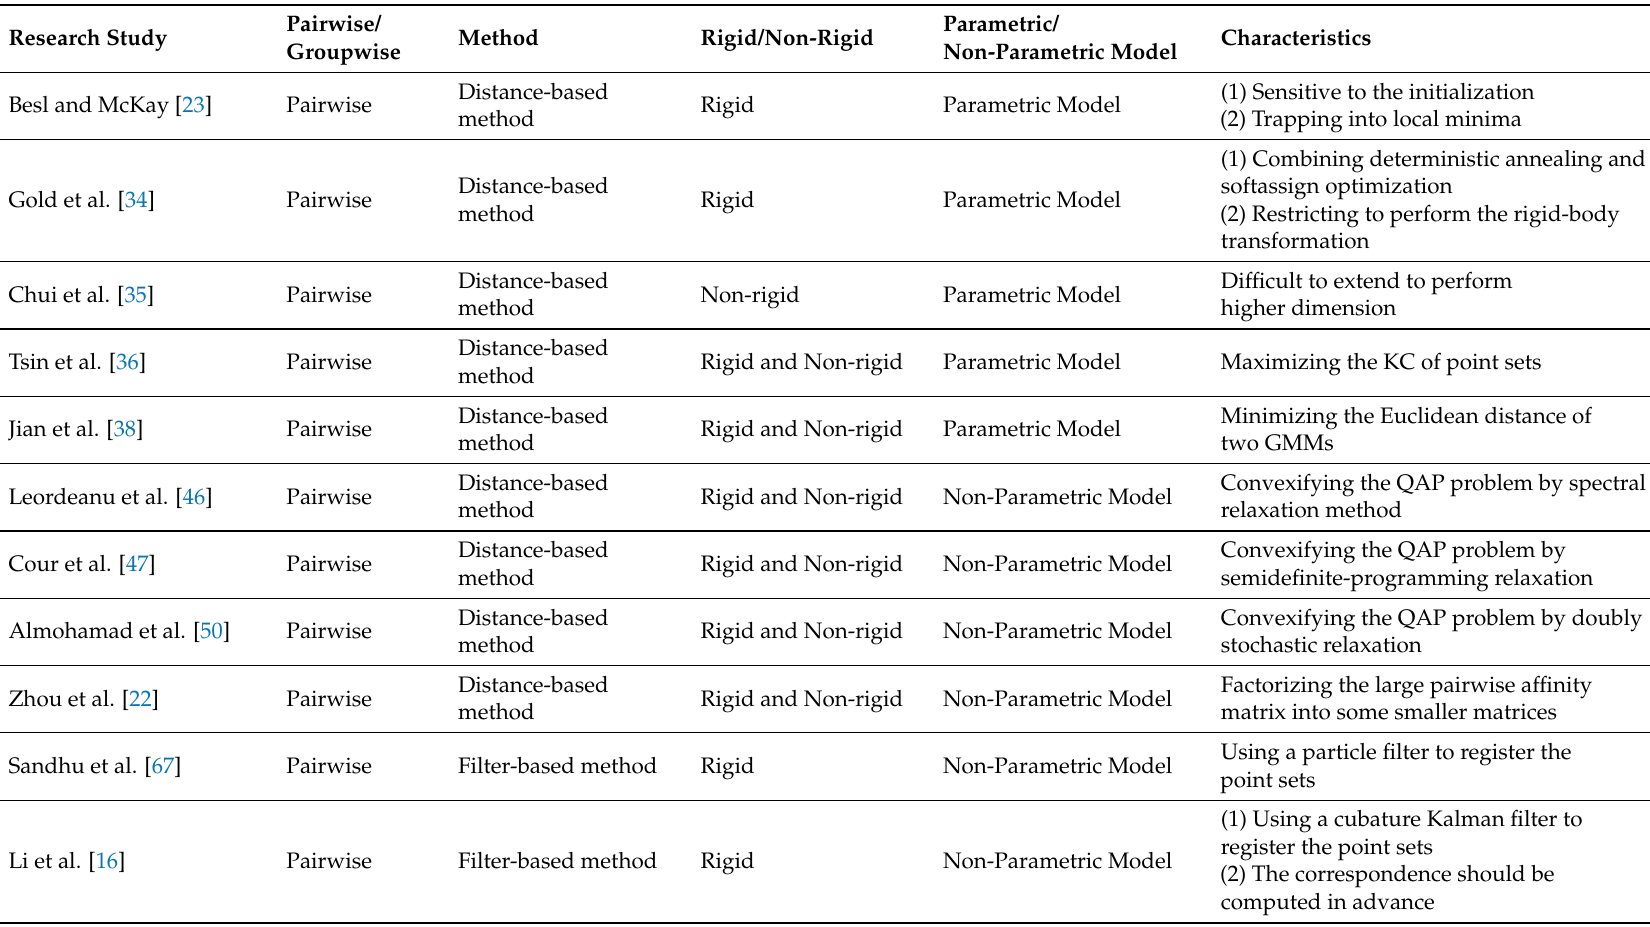
Table 1. The representative methods for point set